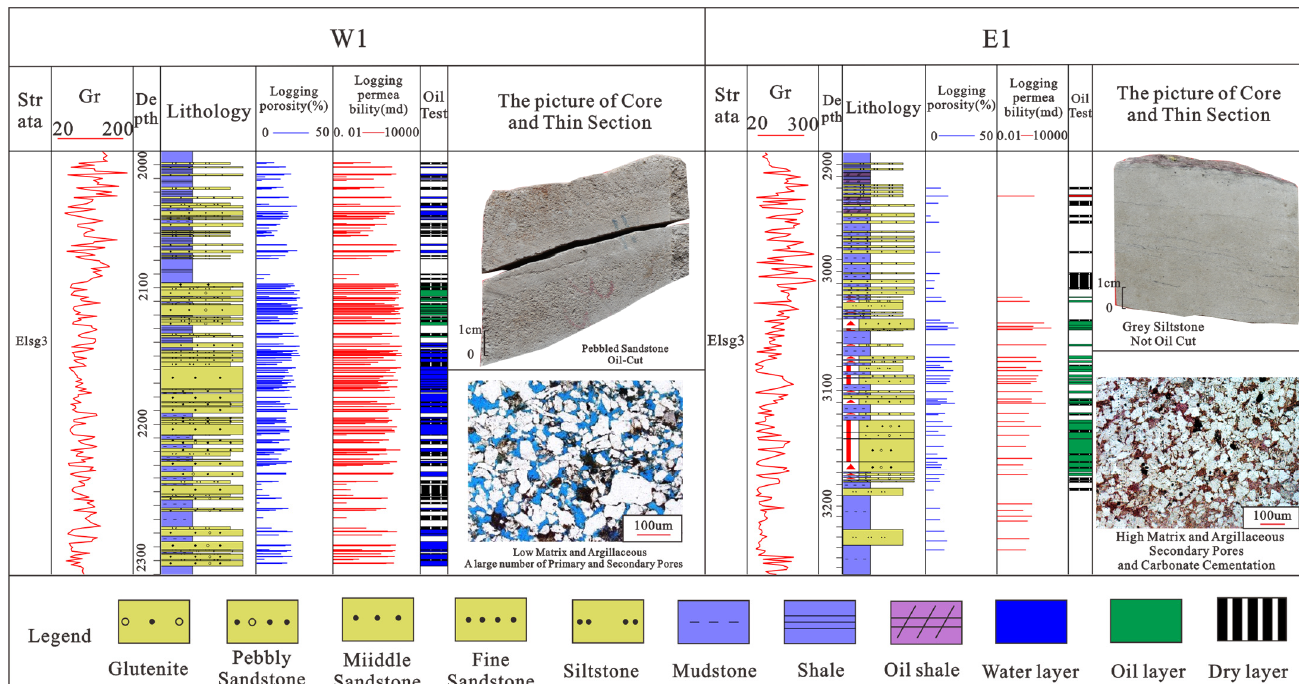
Figure 5. Single-well cores, logging, and reservoir thin sections in the west and east areas (well W1 (the well location is shown in Figure 1C) in the west, with good physical properties, and well E1 (the well location is shown in Figure 1C) in the east, with poor physical properties).